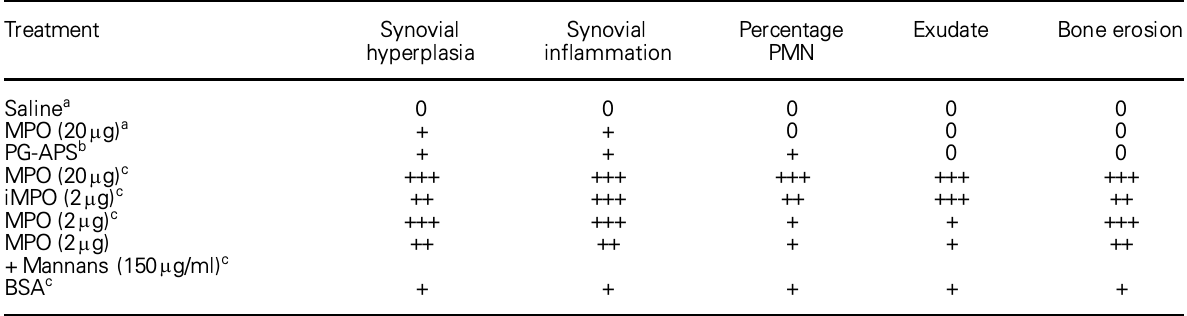
a Values represent the pathology observed after 3 weekly IA injections without an initial injection of PG-APS. b Pathology at 3 weeks after a single injection of PG-APS and 3 weekly injections of saline. c Values represent the pathology observed after a single 10 m l injection of PG-APS followed by 3 IA injections of the stated treatment. Each injection was administered after the joint had returned to baseline level of swelling. Amounts in parenthesis represent the concentration injected in the joint. Data represent the mean of at least 4 different animals. Key: Synovial hyperplasia; 0 = 0–2 layers, + = 3,4 layers, ++ = 5,6 layers, +++ = >6 layers. Synovial inflammation; 0 = <2 lymph, + = inflamm (not crowded), ++ = inflamm (cell crowded), +++ = diffuse. % PMN; 0 = <1%, + = <10%, ++ = 11–20%, +++ = >30%. Exudate; 0 = <1%, + = <10%, ++ = 11–20%, +++ = >30%. Bone erosion; 0 = none, + = only edge 1–2 joint surfaces or juxta bone, ++ = more extensive over surface or 2–5 foci, +++ = more extensive or >5